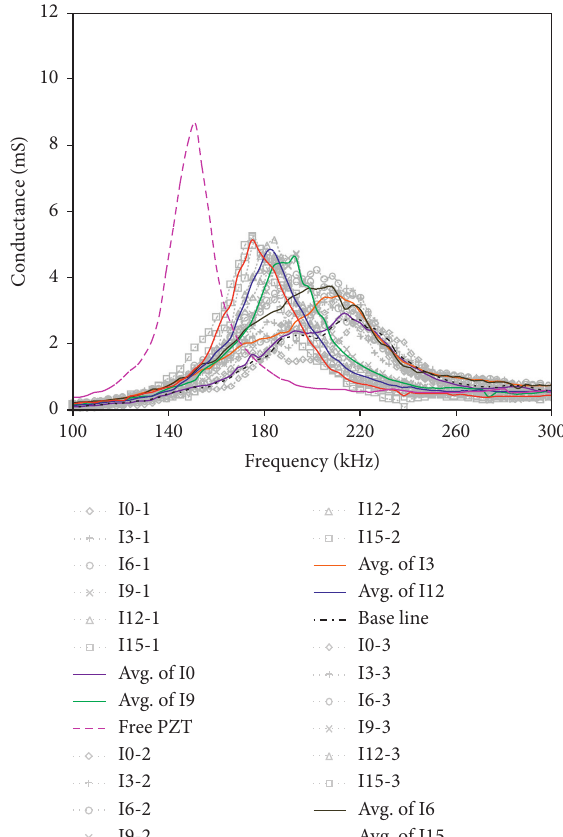
Figure 5: Influence of impact loading on the conductance signatures of PZT transducers.